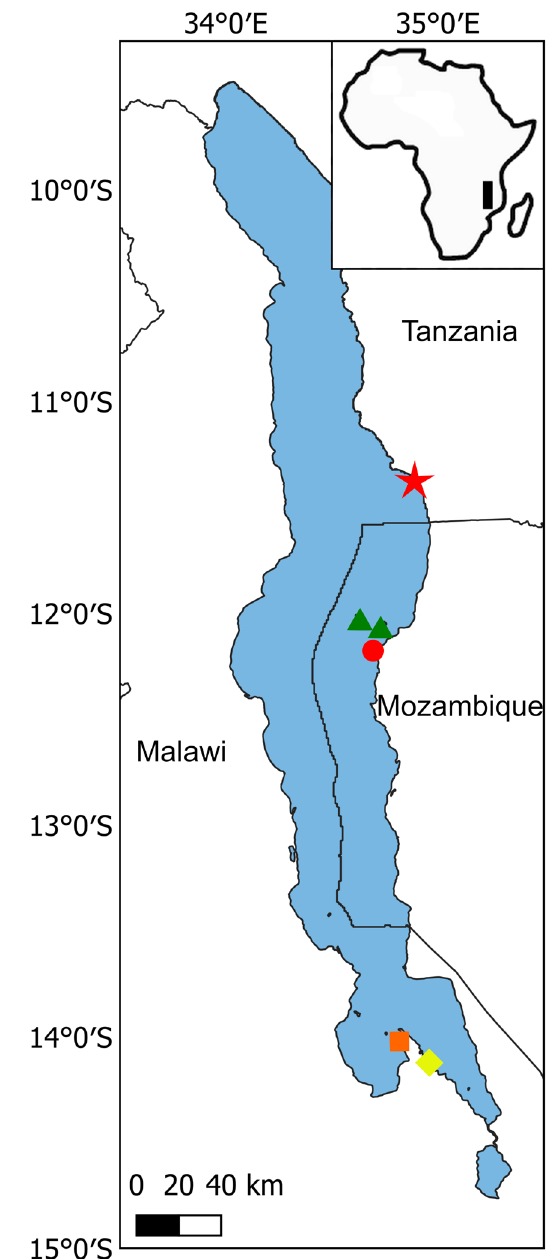
Fig. 7. Distribution map of Protomelas krampus sp. nov. Red star = holotype; red dot = paratype; green triangles = possible sightings by Konings (2016); orange square = possible sighting by McKaye & Kocher (1983); yellow diamond = possible sighting by Stauffer (pers. comm.). Inset: map of Africa with indication of area of Lake